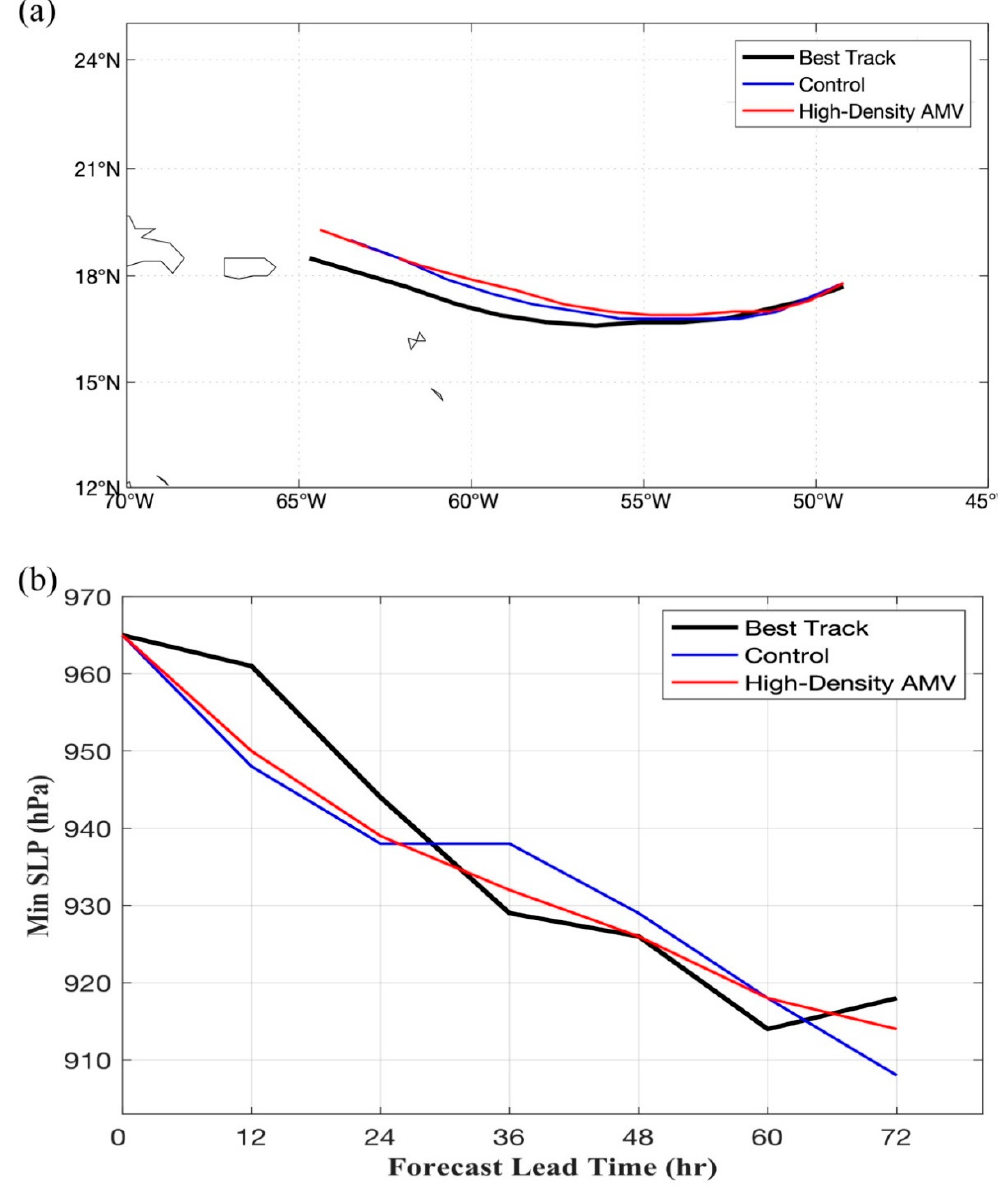
Figure 17. ( a ) Irma best track (black line) between 18 UTC 3 September and 18 UTC 6 September as in Figure 10b compared with CIMSS Control HWRF track forecast (blue line) and high-density AMV HWRF track forecast (red line). ( b ) As in panel ( a ), except for MSLP (hPa) instead of track (provided by William E. Lewis, CIMSS).